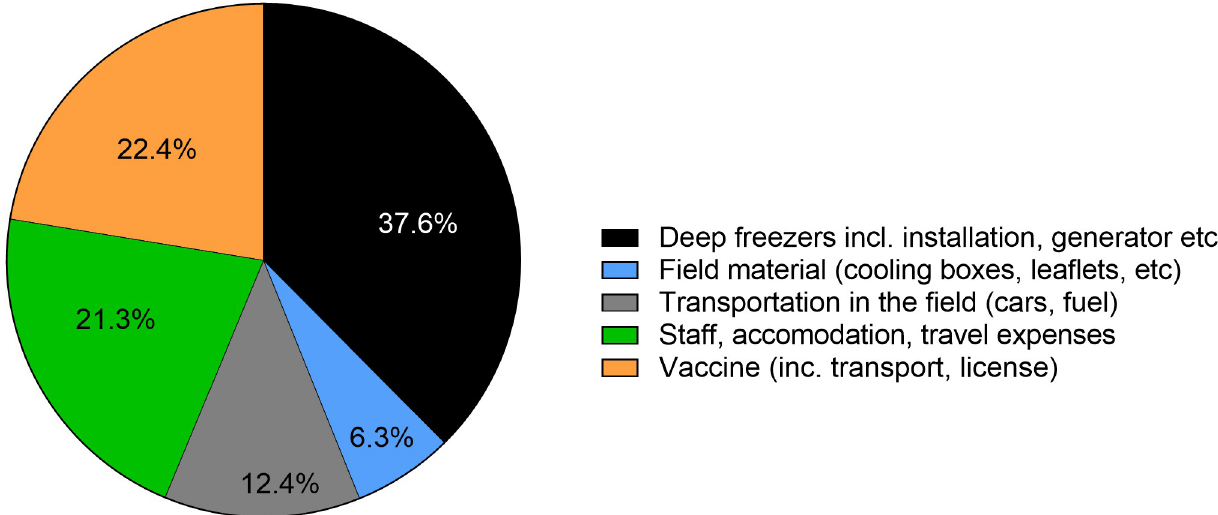
Fig 7. Pie-chart showing the percent shares of different costs, with a total budget of 51.045 US$.